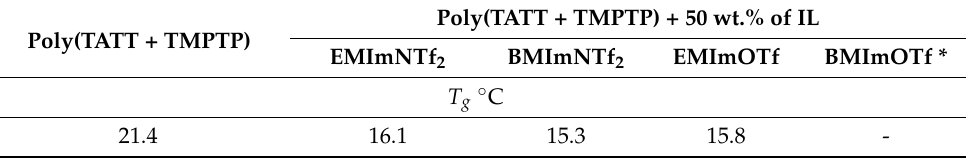
Table 1. Glass temperature of investigated ionogels with 50% of